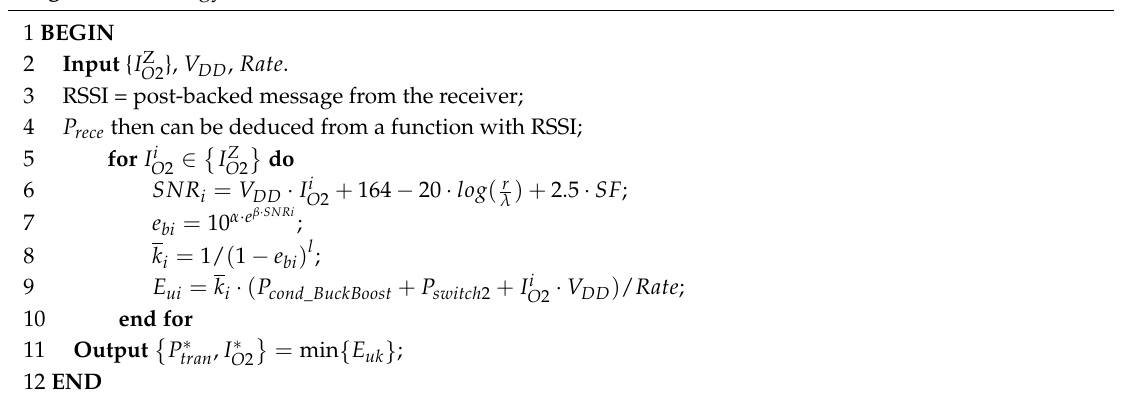
Algorithm 4 Energy Efficient Transmission Power